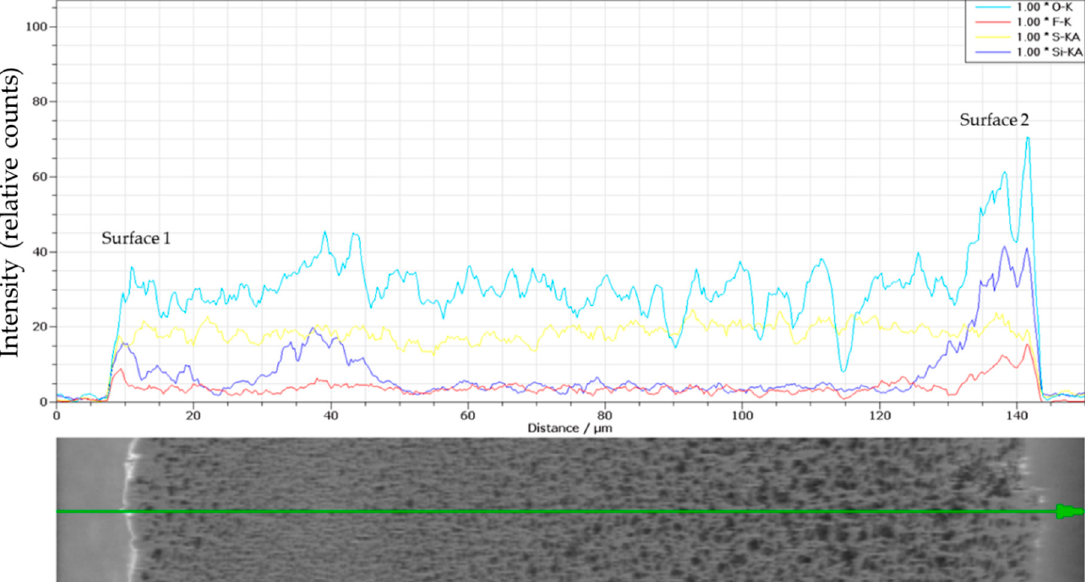
Figure 8. EDX (energy-dispersive X-ray spectroscopy) spectra of the cross section for membrane 3.